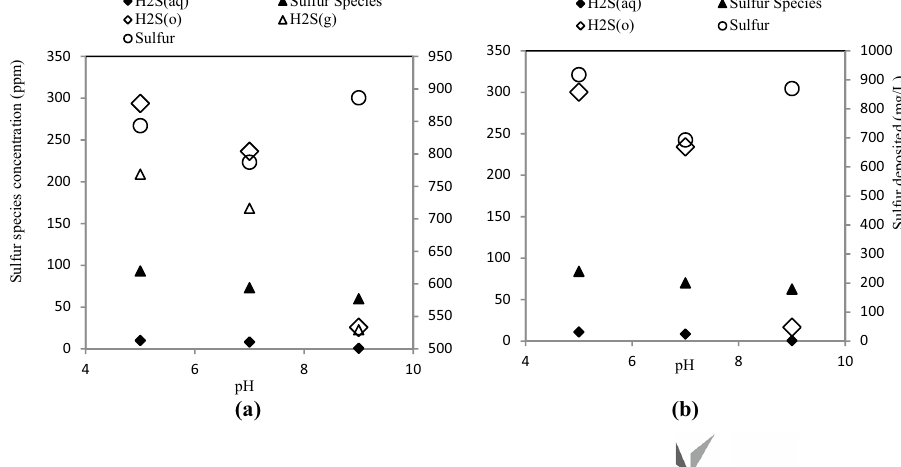
Fig. 4 The effect of pH on sulfur speciation, solid-phase formation, and H 2 S partitioning, aqueous-phase reactions, a T : 25 °C, P : 1 MPa, b T : 75 °C, P : 25 MPa (sulfur species is the total concentration of sulfate, sulfite, polysulfide ions, and